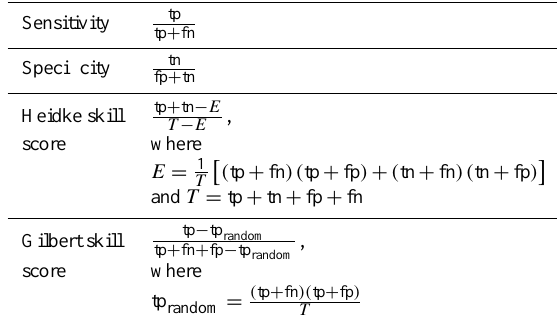
Table 1. Performance statistics. tp: true positives, tn: true negatives, fp: false positives, fn: false negatives. T equals total number of fore- casts, and E equals the expected number of correctly classified sam- ples due to random